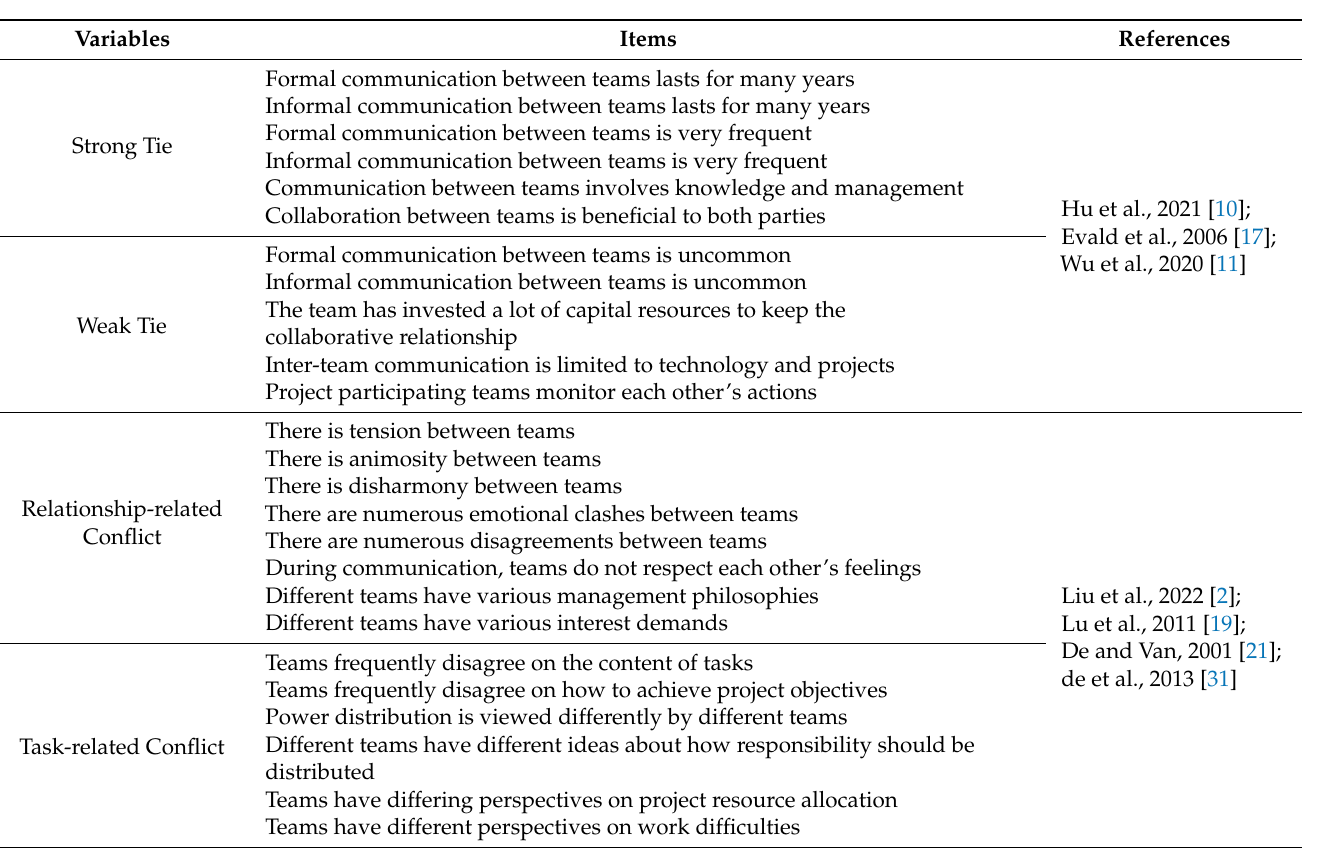
Figure 2. Normal distribution test. Table 1. Measurement